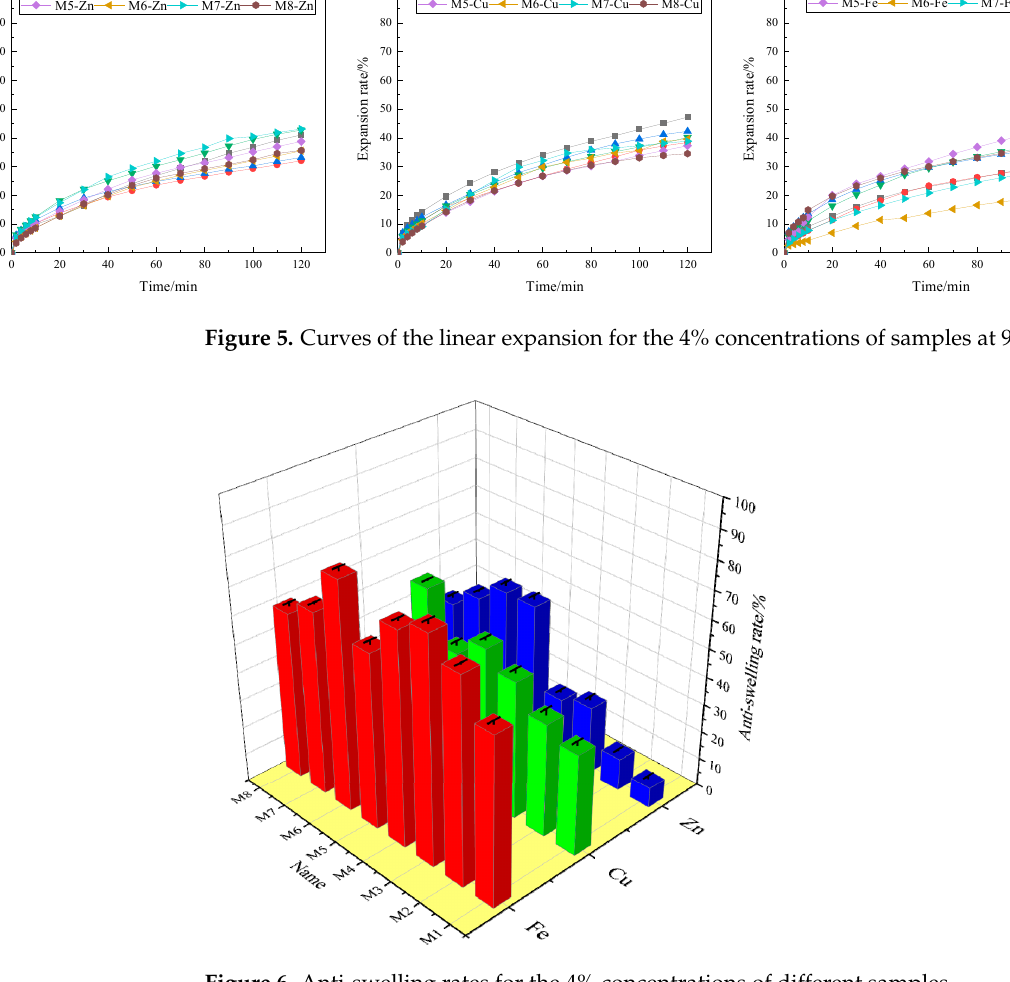
Figure 6. Anti-swelling rates for the 4% concentrations of different samples.